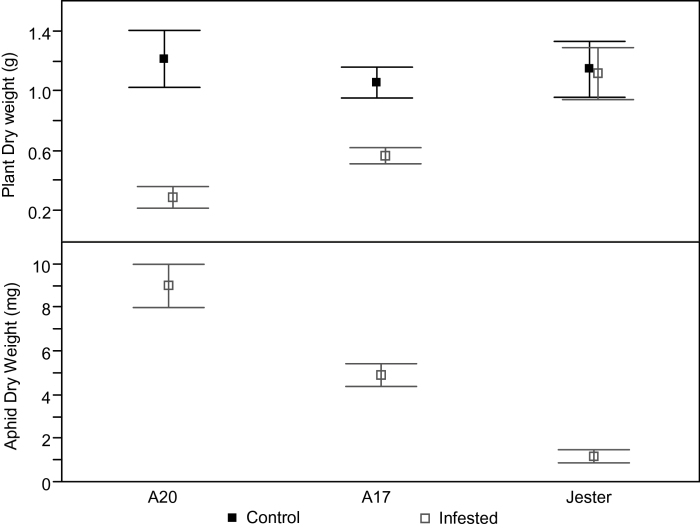

M. truncatula accessions differ in their response to SAA infestation measured as SDW and on their effect on total ADW per plant at 21 dpi. Plants were each infested with 50 adult aphids in a complete randomized non-choice experiment. For each experiment, n=10. Full-factorial ANOVA resulted in a significant interaction between treatment and accession (F
Acc×Treat<0.0001, df=2, R
2=0.771). SDW values are represented by means (square symbols); error bars are 95% confidence intervals around the mean.